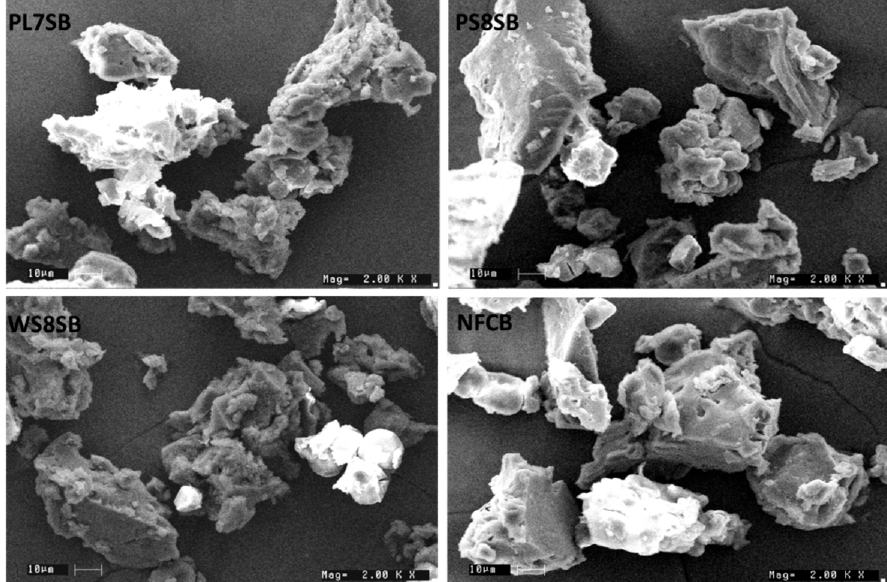
Figure 3. Scanning electron micrographs of sourdough breads (SB) obtained with different LAB strains and control bread. PL7SB (SB with Pediococcus pentosaceus LD7); PS8SB (SB with Pediococcus pentosaceus SA8); WS8SB (SB with Weissella confusa SD8), NFCB (control bread without